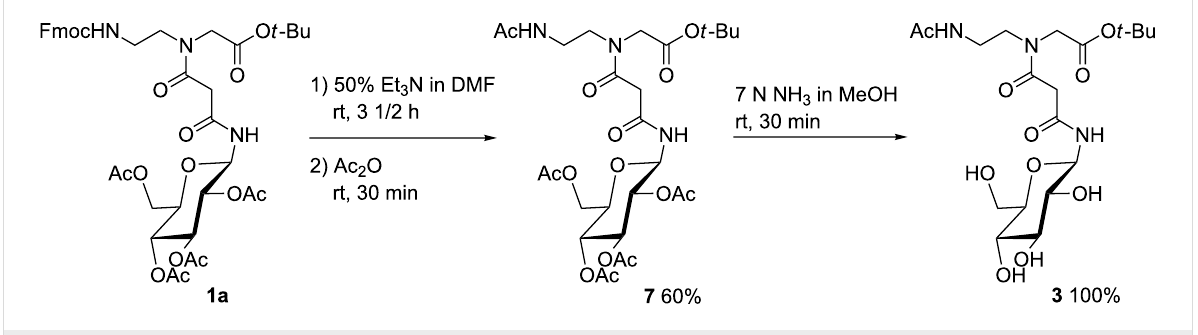
Scheme 2: Synthesis of building block 3 .